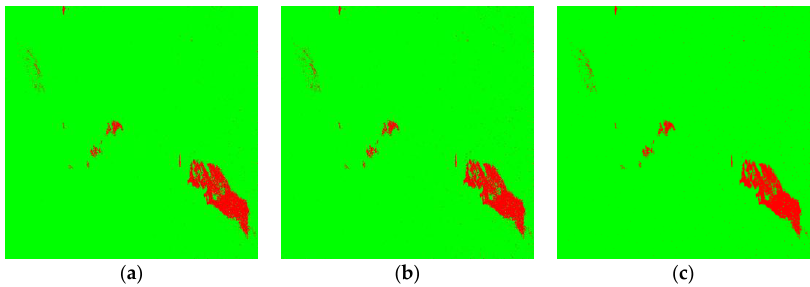
Figure 5. Classification results based on quad-pol SAR features using different classifiers. ( a ) SVM; ( b ) ML; ( c ) ANN. Table 4. Confusion matrix achieved by SVM based on 8 fully polarimetric features.